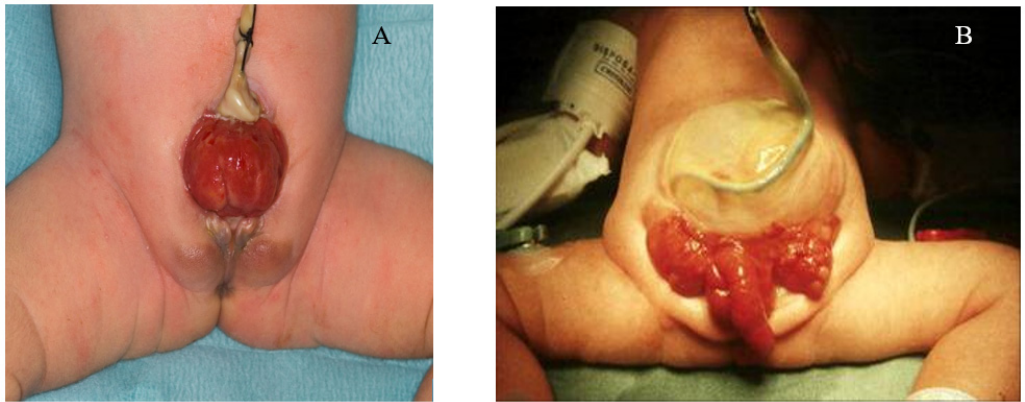
Figure 1. ( A ) Female with classic bladder exstrophy; ( B ) male with cloacal exstrophy.